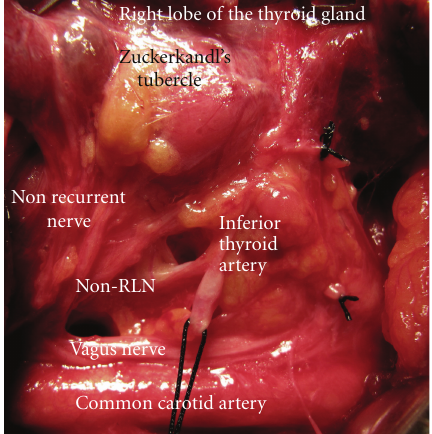
Figure 1: The right Zuckerkandl’s tubercle as a posterior extension of the right lateral lobe, points the nonrecurrent inferior laryngeal nerve (non-RLN). It arises from the vagus nerve and courses direct- ly to laryngeal entry.